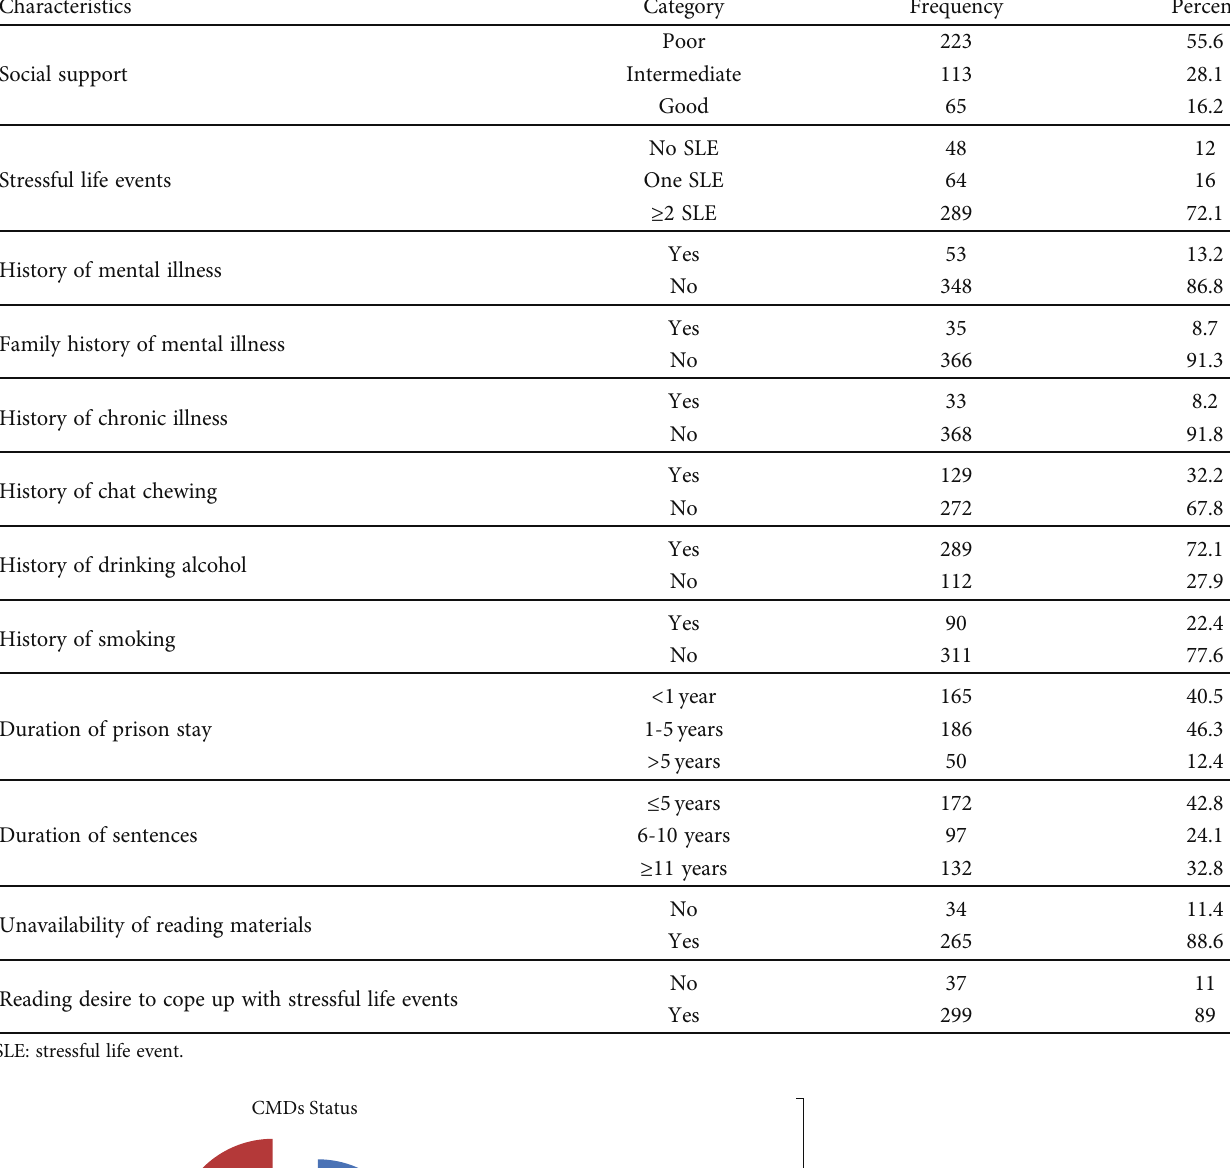
Table 3: Distribution of psychosocial and other characteristics of prisoners in North Wollo zone correctional institutions, Northeastern Ethiopia.